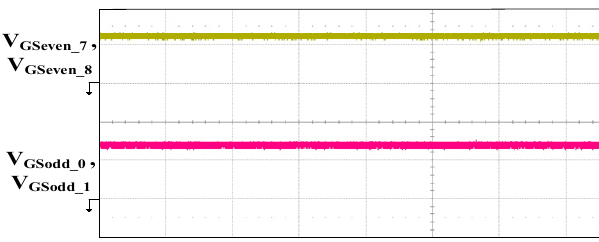
Figure 17. Experiment of V GS triggering waveforms for the switch network (V GSodd_0 , V GSodd_1 , V GSeven_7 , V GSeven_8 ), V GSodd_0 , V GSodd_1 , V GSeven_7 , V GSeven_8 : 10 V/div, Time: 20 µs/div.